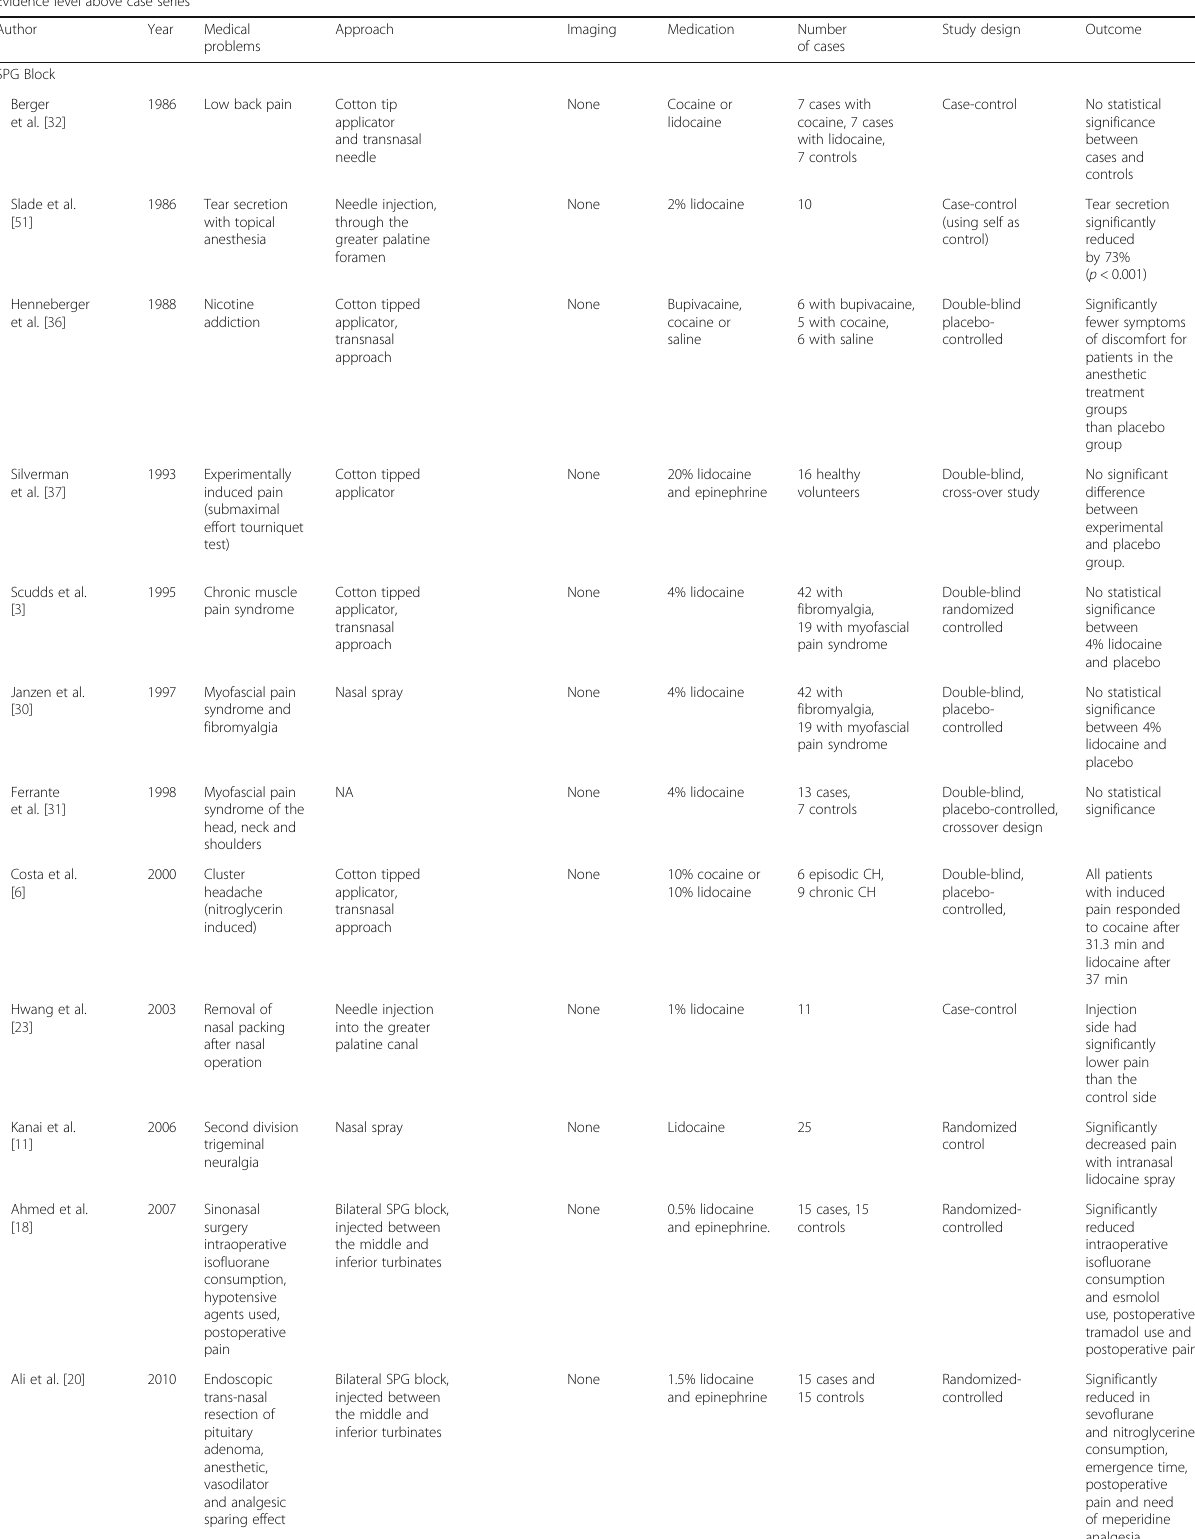
Table 2 Studies with evidence level above case series in SPG block, radiofrequency ablation and neurostimulation Evidence level above case